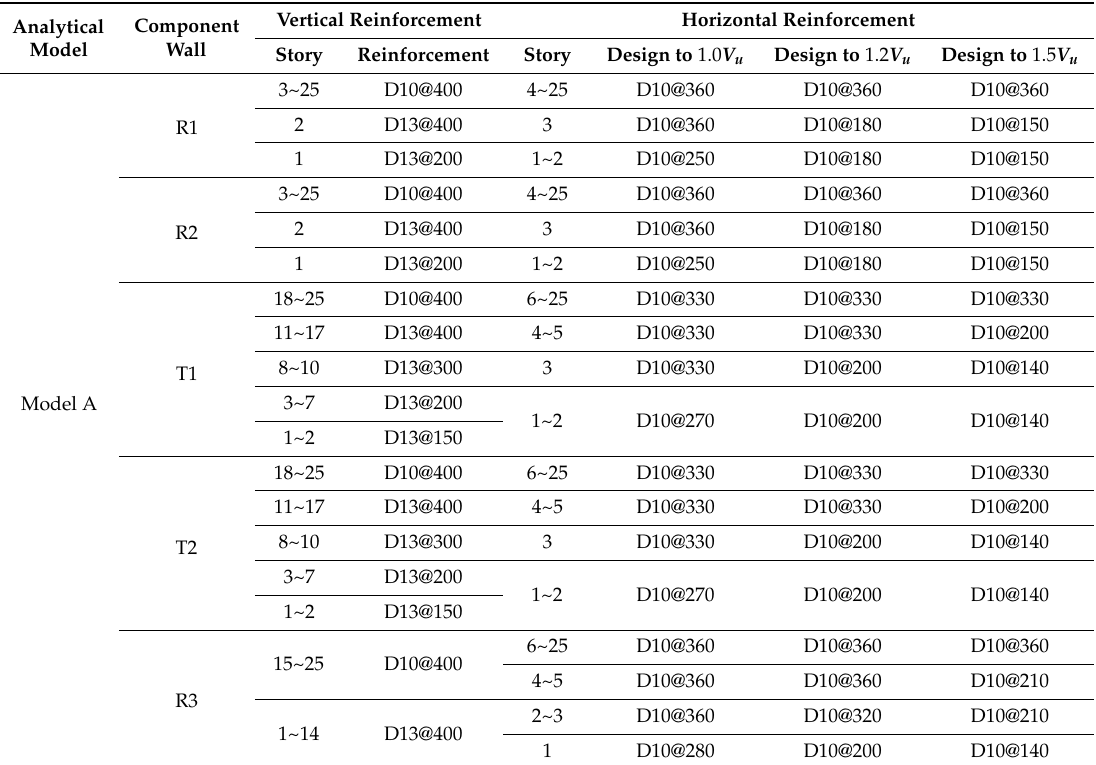
Table 5. Reinforcement of shear